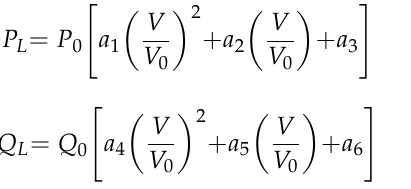
Table 1. Parameters of the simulated system. Component Parameter Value Unit 275 kV Transmission Lines [32] Power Transformers [32] X